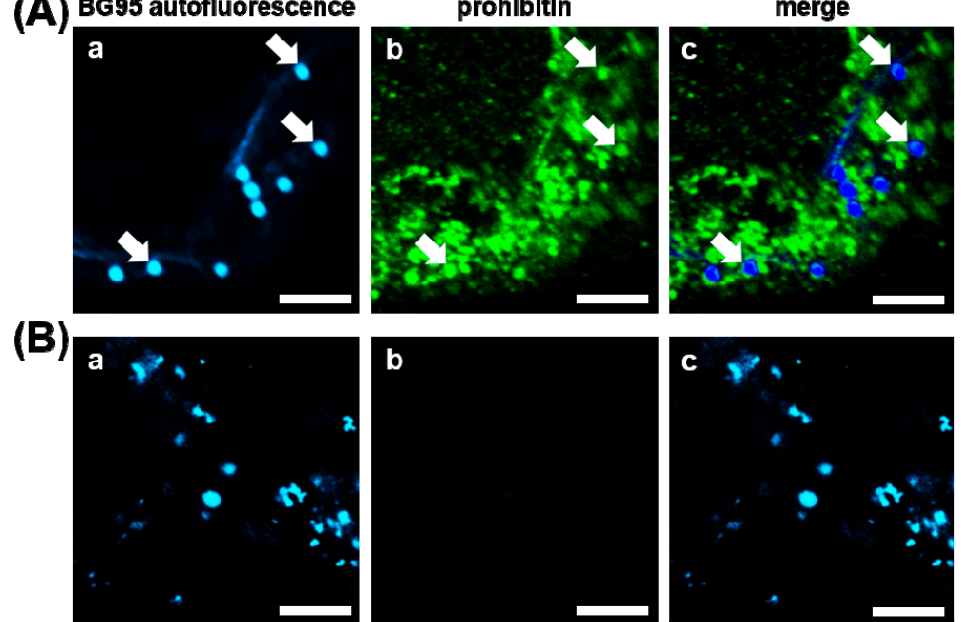
Figure 2. BG95 exhibits pronounced autofluorescence and localizes to mitochondria. ( A ) Autofluorescent BG95 bodies (image a,) were detectable using distinct settings of excitation at 405 nm and emission at 450–590 nm and colocalized with mitochondria of HCMV-infected HFFs stained via mitochondrial marker protein prohibitin (image b). White arrows indicate BG95 bodies and corresponding positions in other channels. ( B ) BG95 autofluorescence did not produce background in the excitation/emission settings employed for prohibitin staining (image b). Scale bars represent 5 µm.